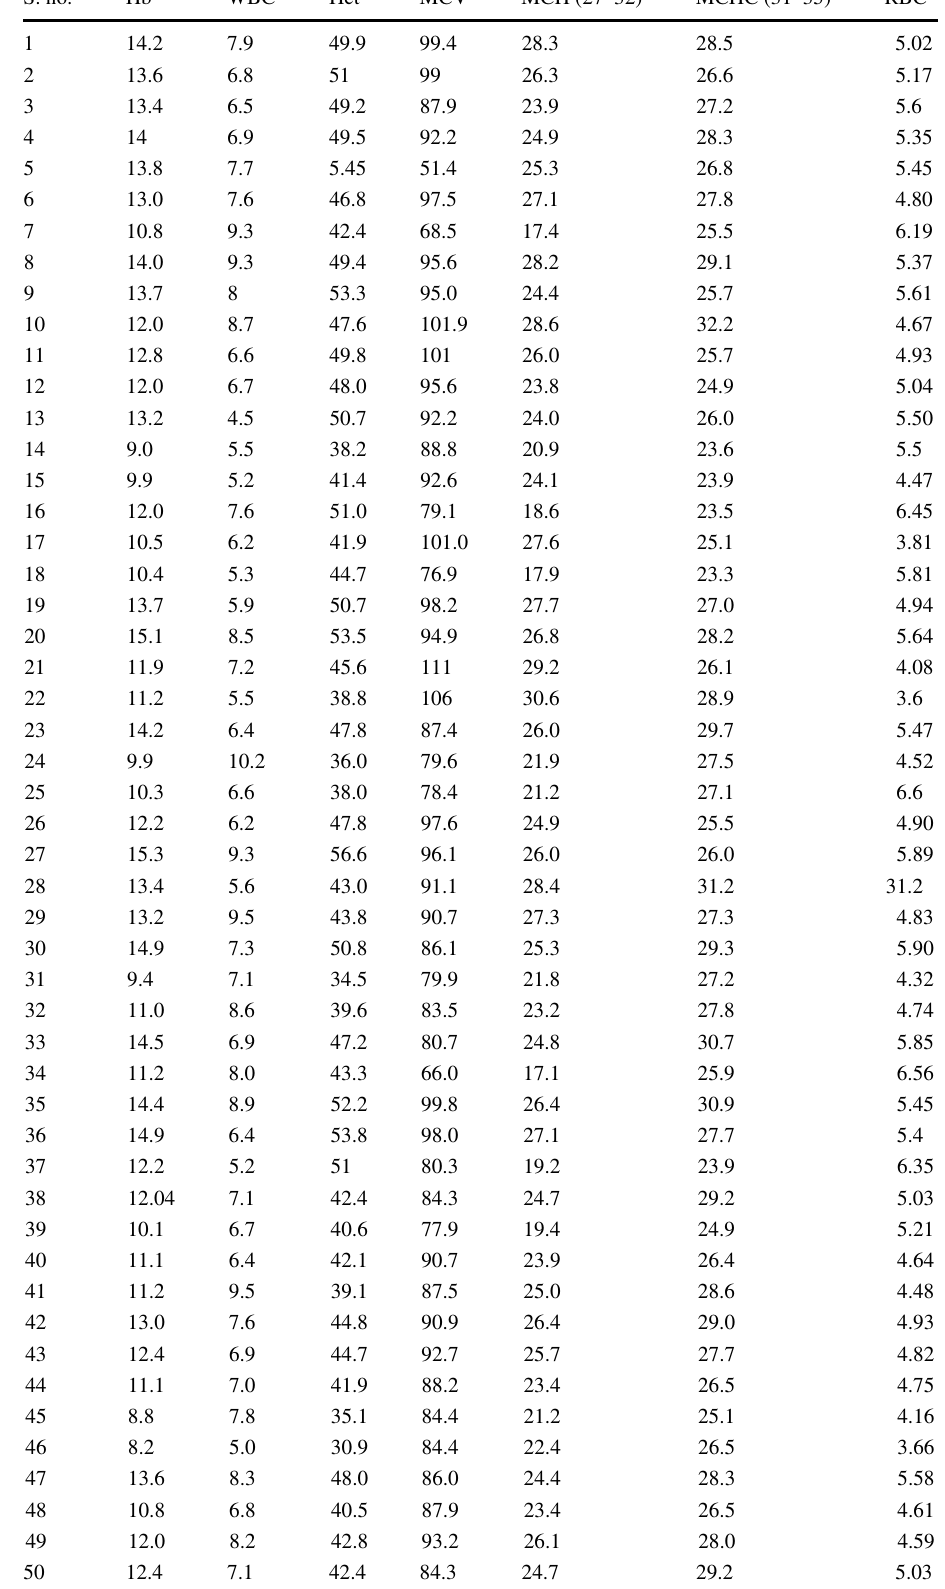
of the sample of 50